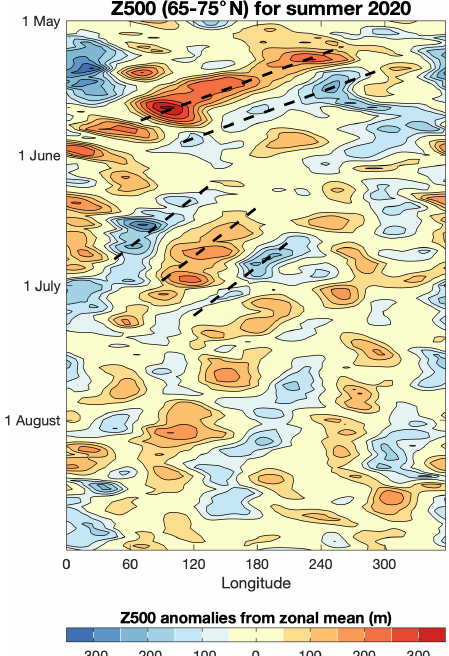
Figure 1. Hovmöller plot of 500hPa geopotential height from the summer of 2020, using daily data from the NCEP reanalysis. Dashed lines are drawn to indicate suggested examples of phase propagation.